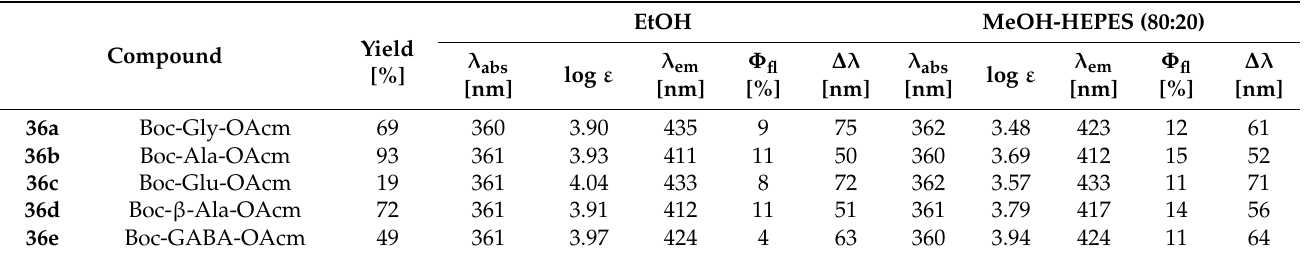
Table 4. Yields, UV/VIS and fluorescence data for esters 36a – e in absolute ethanol and a methanol- HEPES buffer (80:20) solution.